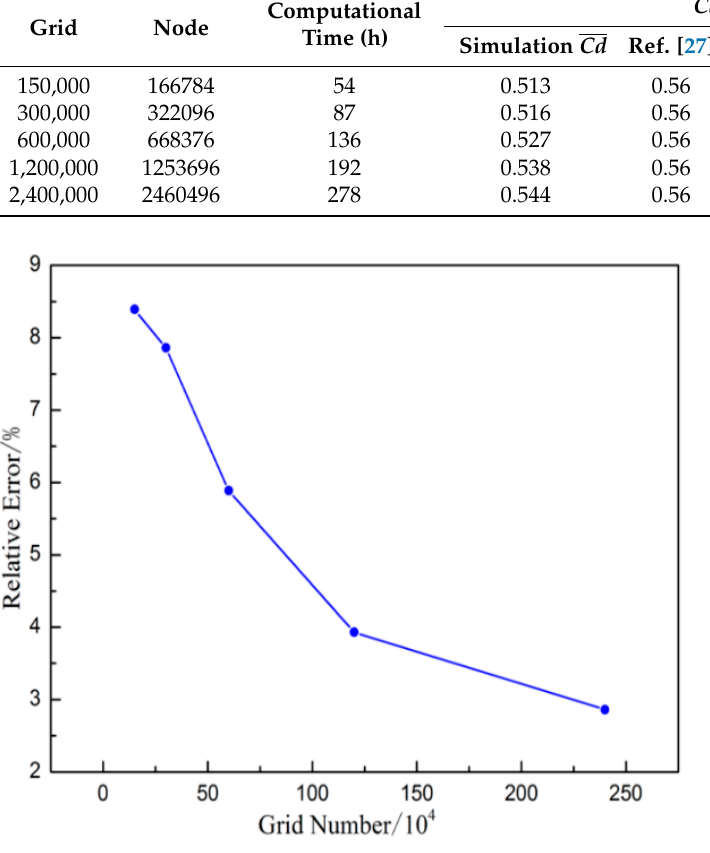
Figure 4. Effect of the grid number on computational error.